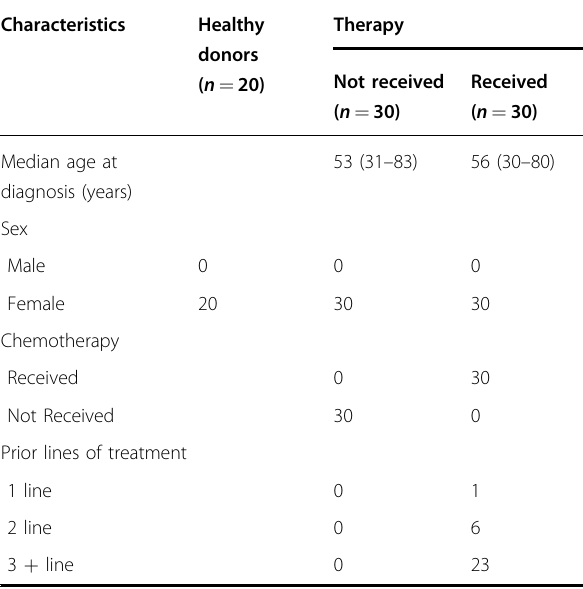
Table 1 Clinicopathological characteristics of breast cancer patients enrolled in this